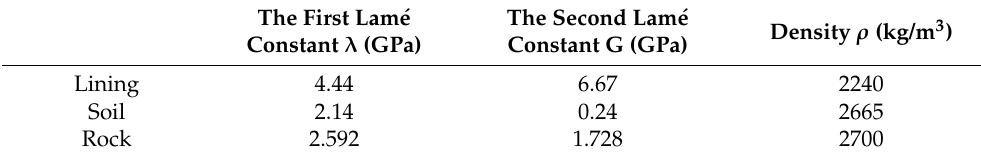
Figure 13. Maximum bending moment of lining under different incident angles of P–SV wave.